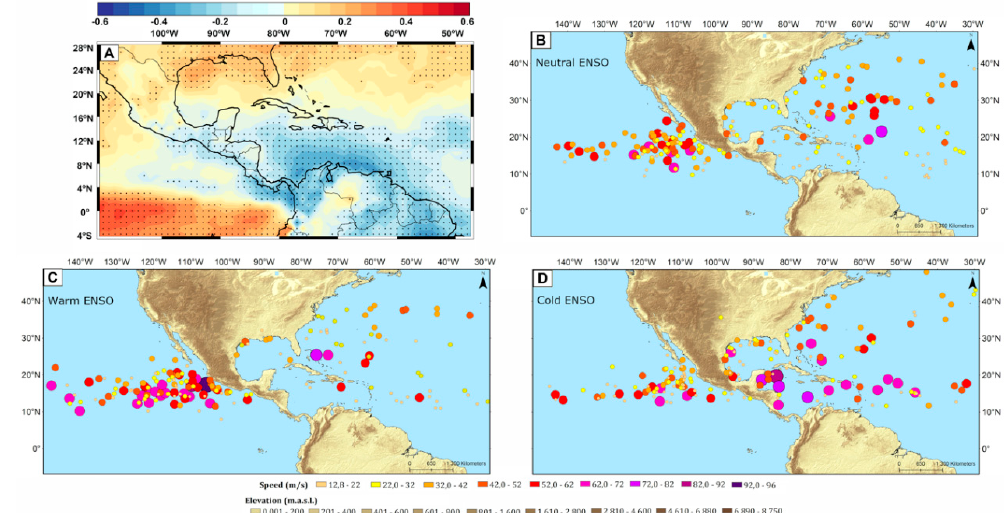
Figure 6. ( A ) Correlation between the Bivariate El Nino– Southern Oscillation Timeseries BEST index and ERA–5 rainfall anomalies (dotted areas indicate statistically significant values, blue shade for warm El Niño–Southern Oscillation (ENSO) lead rainfall reduction, and orange shade for rainfall increase during warm ENSO). Tropical cyclones (TCs) composites for ( B ) warm (1983, 1987, 1992, 1997, 2015), ( C ) cold (1988, 1998, 1999, 2007, 2010), and ( D ) neutral (1981, 1990, 2003, 2012, 2014) ENSO years based on the ENSO 3.4 region sea surface temperature (SST) anomalies for the Atlantic and eastern tropical Pacific based on the HURDAT2 archive. The results highlight differences in the amount and intensity of TCs depending on the ENSO phase, with warm (cold) ENSO featuring reduced (enhanced) cyclonic activity over the Caribbean with a contrasting pattern for the eastern tropical Pacific (ETPac).